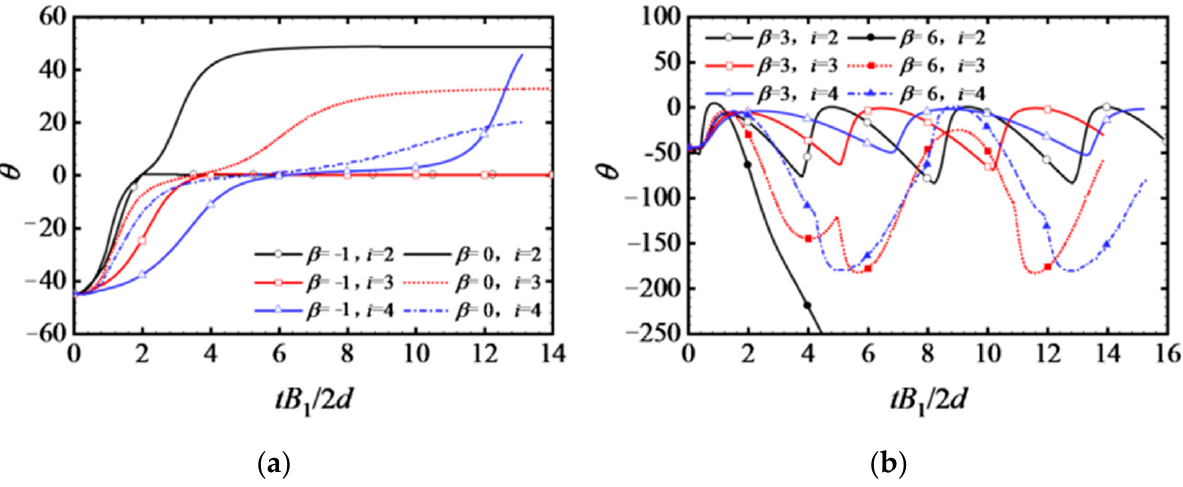
Figure 12. Change in the azimuth of rod-shaped squirmers with different values of i ( Re s = 0.5, s = d ): ( a ) β = − 1 and β = 0; ( b ) β = 3 and β = 6. Ouyang and Phan-Thien [36] studied the motion of rod-shaped squirmers in an infinite flow, and found that the larger i is, the less likely the squirmer is to deviate from the original rotated under the action of the wall, and the degree of the effect of the flow at the previous moment on the squirmer’s motion was different for squirmer with different values of i . The difference in the flow structure around the squirmer and its own inertia (mass, moment of